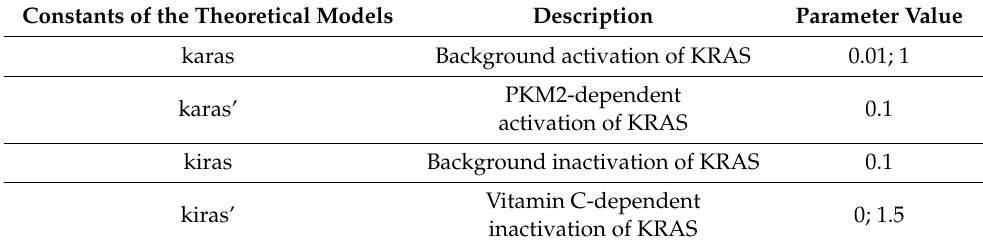
Table A2. The detailed description of the constants of the theoretical models and their value in physiological